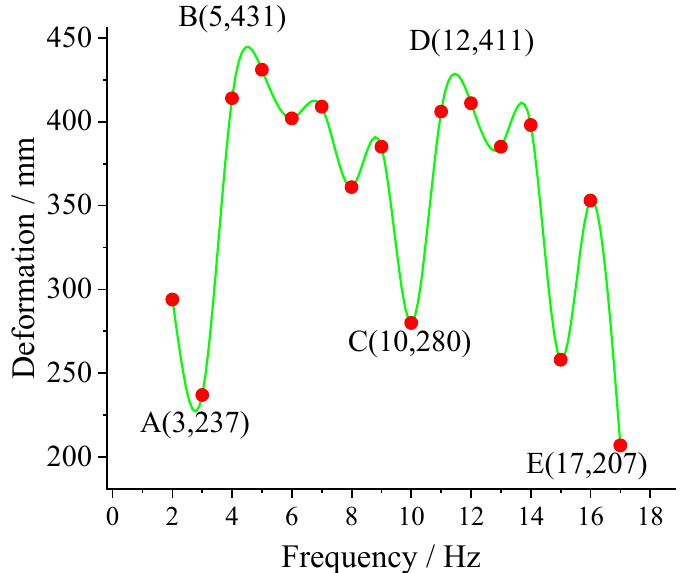
Figure 6. Line chart of frequency and deformation response of Camellia oleifera . A, B, C, D and E represent the excitation frequencies with typical displacement characteristics.